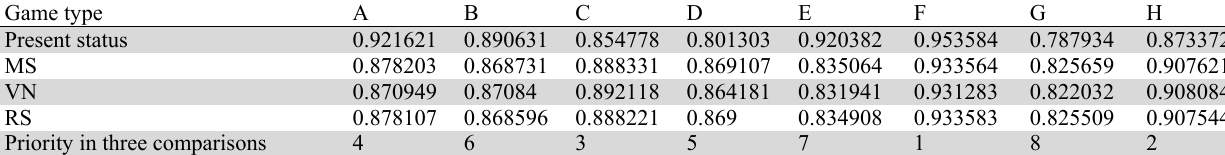
Prioritization of manufacturers based on customer satisfaction